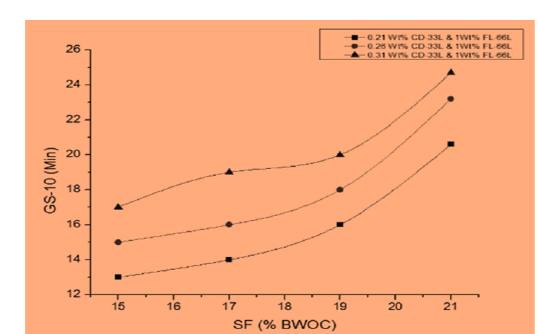
FIG. 9. COMBINED ADDITIVE EFFECTS ON GS-10 MIN OF 13 PPG